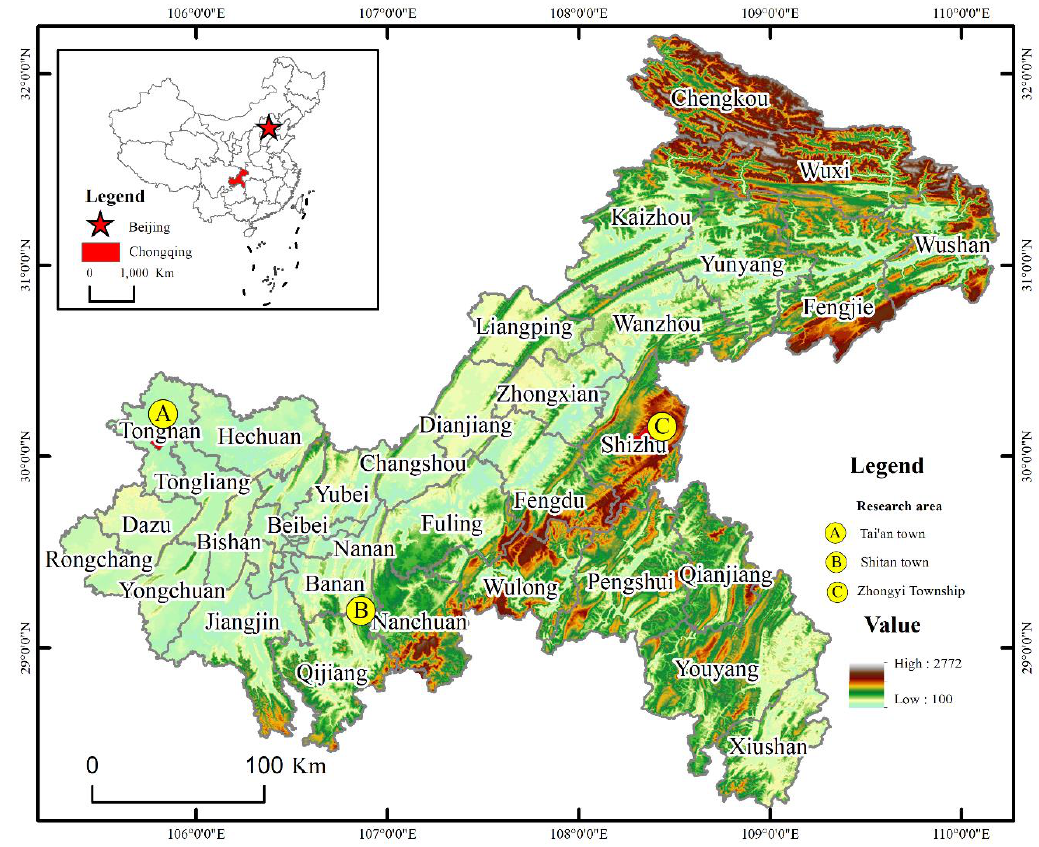
Figure 1. Schematic diagram of the study